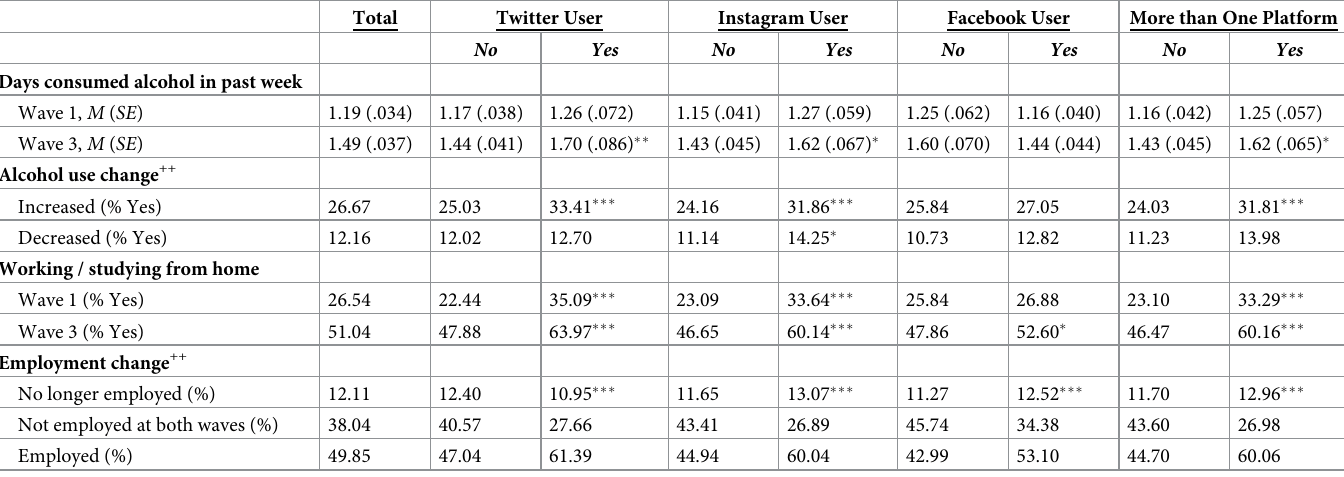
Table 2. Alcohol use and work status by social media use ( N =